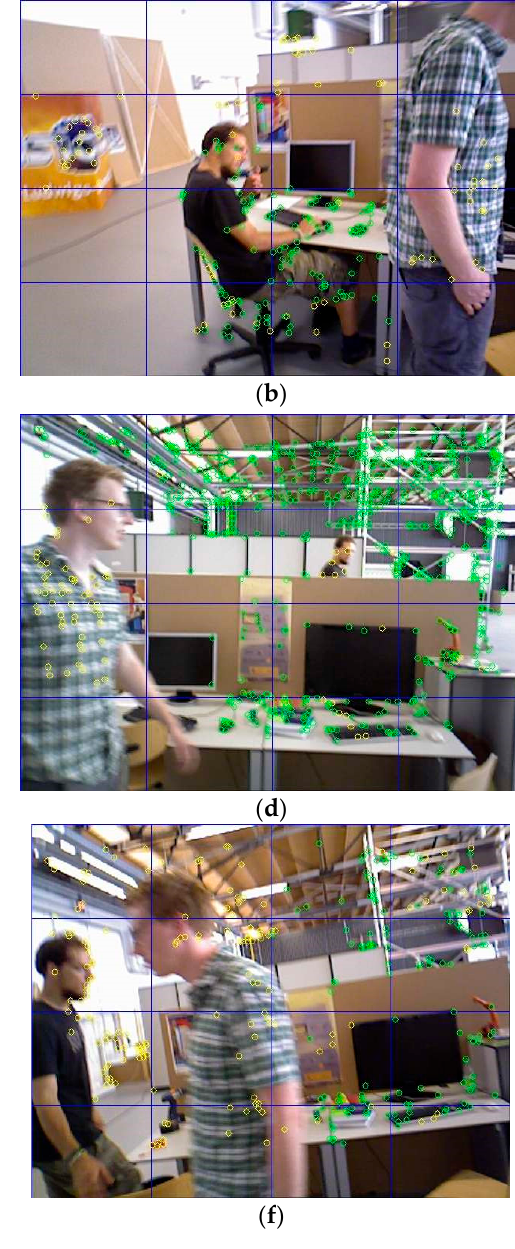
Figure 2. Static features extraction results of different frames in sequence fr3_walking_rpy. Inliers are marked with green circle, while yellow circles are considered to be outliers. (a-f) depicts the movement scene at different moments in TUM fr3_walking_rpy.